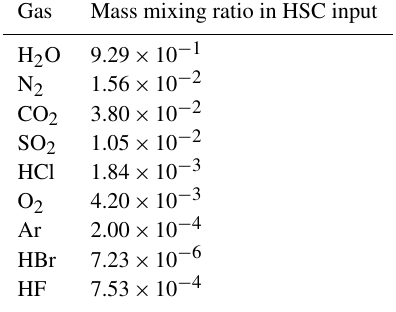
Table 3. Composition inputs to the HSC Chemistry model assuming a plume–air mixture of 98:2 magmatic:atmospheric gases, with temperatures of 1125 and 20 ◦ C, resulting in a mixed temperature of 1103 ◦ C. Resulting output of the HSC Chemistry simulations were converted to ratios relative to sulfur and used to initialize the S1_HighT model simulation (second row of Table 4). The HSC Chemistry model is presented in Sect.